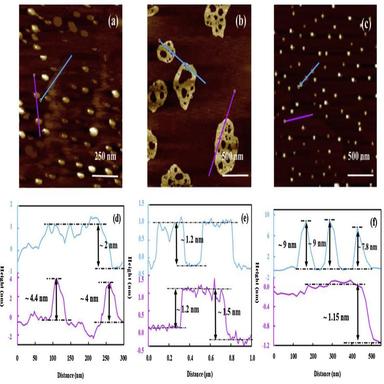
AFM images of the (a) LEC-800, (b) LEC-900 and (c) LEC-1000 samples and height sensor data for (d) LEC-800, (e) LEC-900 and (f) LEC-1000.